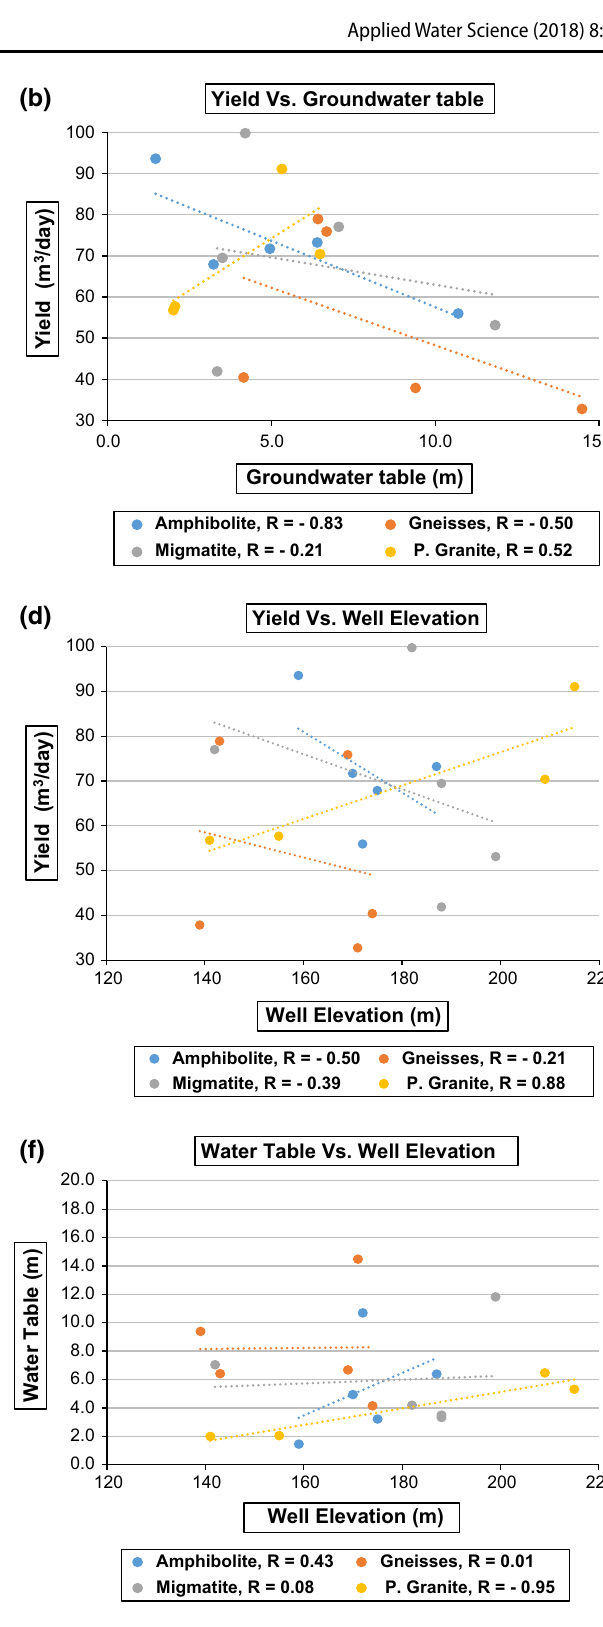
Fig. 11 a Plot of groundwater yield against well depth. b Plot of groundwater yield against water table. c Plot of well depth against groundwater table. d Plot of groundwater yield against well elevation.